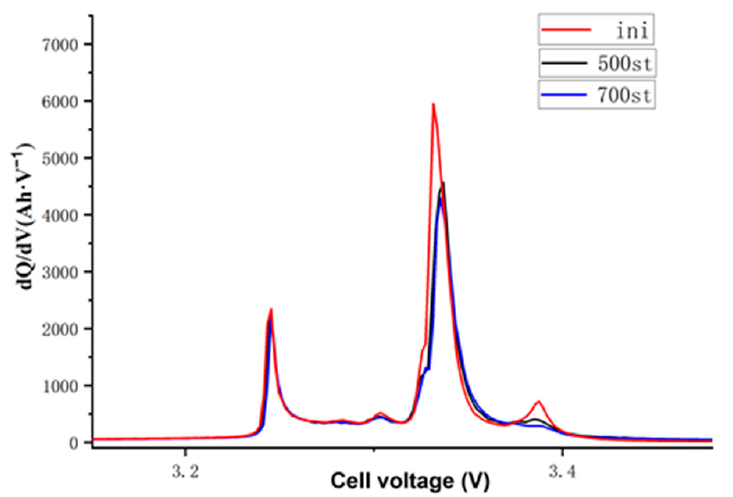
Figure 4. IC curve decay trend.